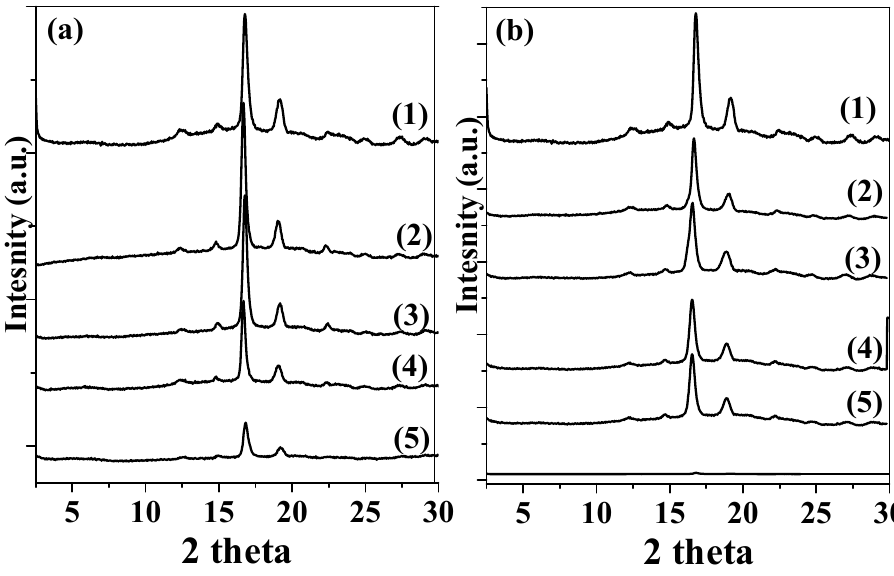
Figure 2. XRD plots of ( a ) (2) PLLA/CS5, (3) PLLA/CS10, (4) PLLA/CS20, and (5) PLLA/CS30 as well as ( b ) (2) PLLA/CS/BO5, (3) PLLA/CS/BO10, (4) PLLA/CS/BO20, and (5) PLLA/CSB/O30: in the upper part of both graphs (line (1)) is the corresponding “blank” PLLA XRD plot for